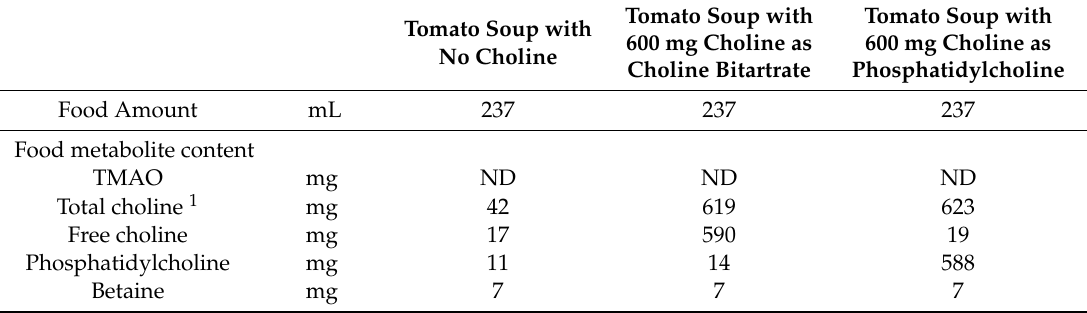
Table 2. Food amount and metabolite content of trimethylamine- N -oxide (TMAO), total choline, free choline, phosphatidylcholine and betaine in tomato soup containing (i) 600 mg choline as choline bitartrate; (ii) 600 mg choline as phosphatidylcholine; or (iii) no choline control.